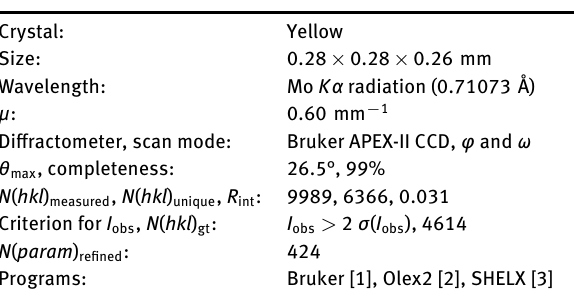
Table 1: Data collection and